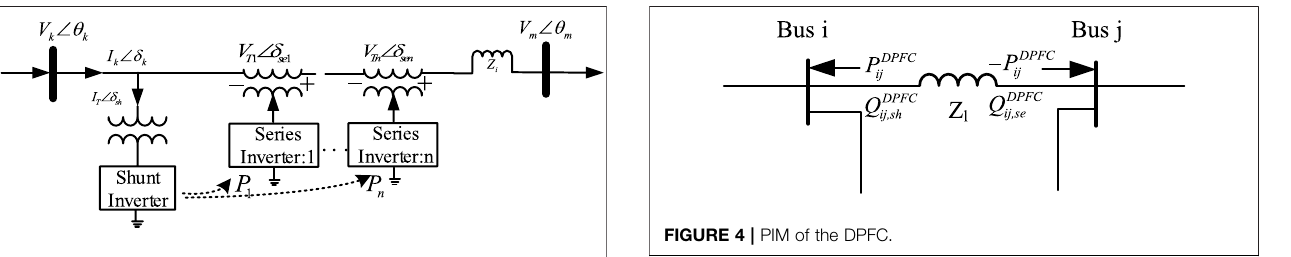
FIGURE 2 | Simpli fi ed DPFC circuit diagram.